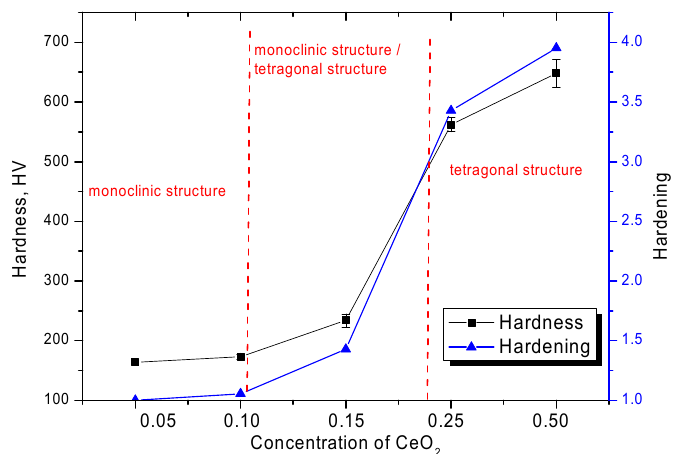
Figure 5. Results of the change in the hardness of ceramics depending on the CeO 2 concentration.